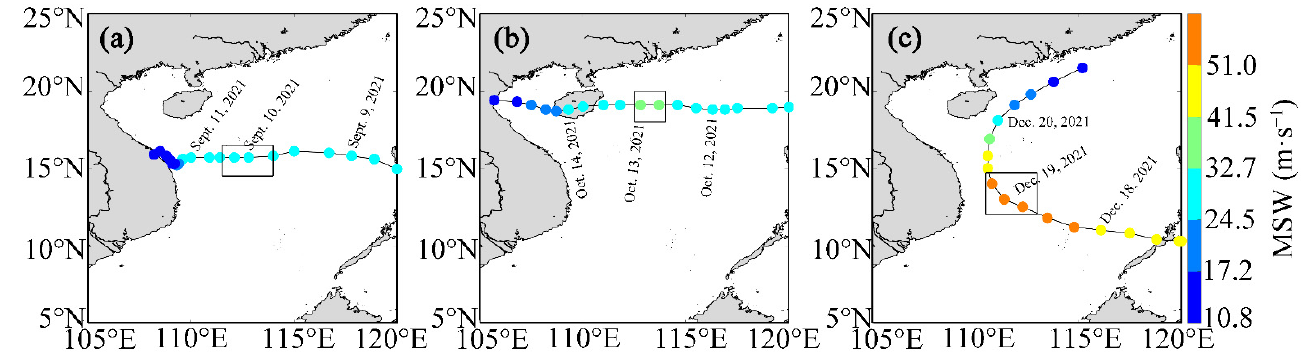
Figure 2. Track and intensity of ( a ) STS “Conson”, ( b ) TY “Kompasu”, ( c ) STY “Rai” in the SCS. MSW: maximum sustained wind speed (m · s − 1 ). The solid circles with different colors represented different MSW. The three black boxes were the study areas of the three tropical cyclones marked in Figure 1. Dates were given as “mm dd, yy”.